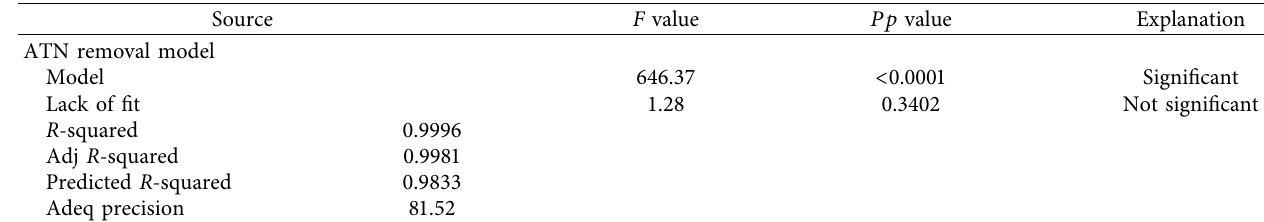
Figure 1: Plot (a) predicted against experimental results and (b) normal probability plot of residuals. Table 4: ANOVA for the response surface quadratic